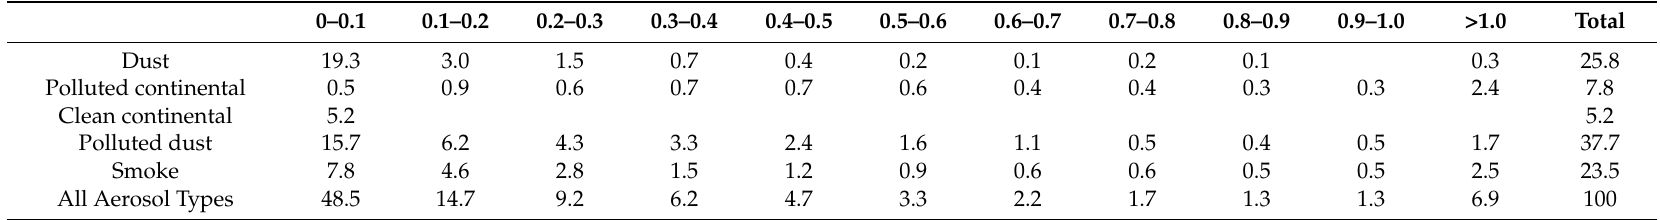
Table 2. Statistics of the probability distribution of the AOD of five aerosol subtypes defined by CALIPSO over central China from March 2007 to February 2016 (unit: %). The numbers shown in the first line are AOD intervals. The clean marine aerosol is not shown, because it is negligible in